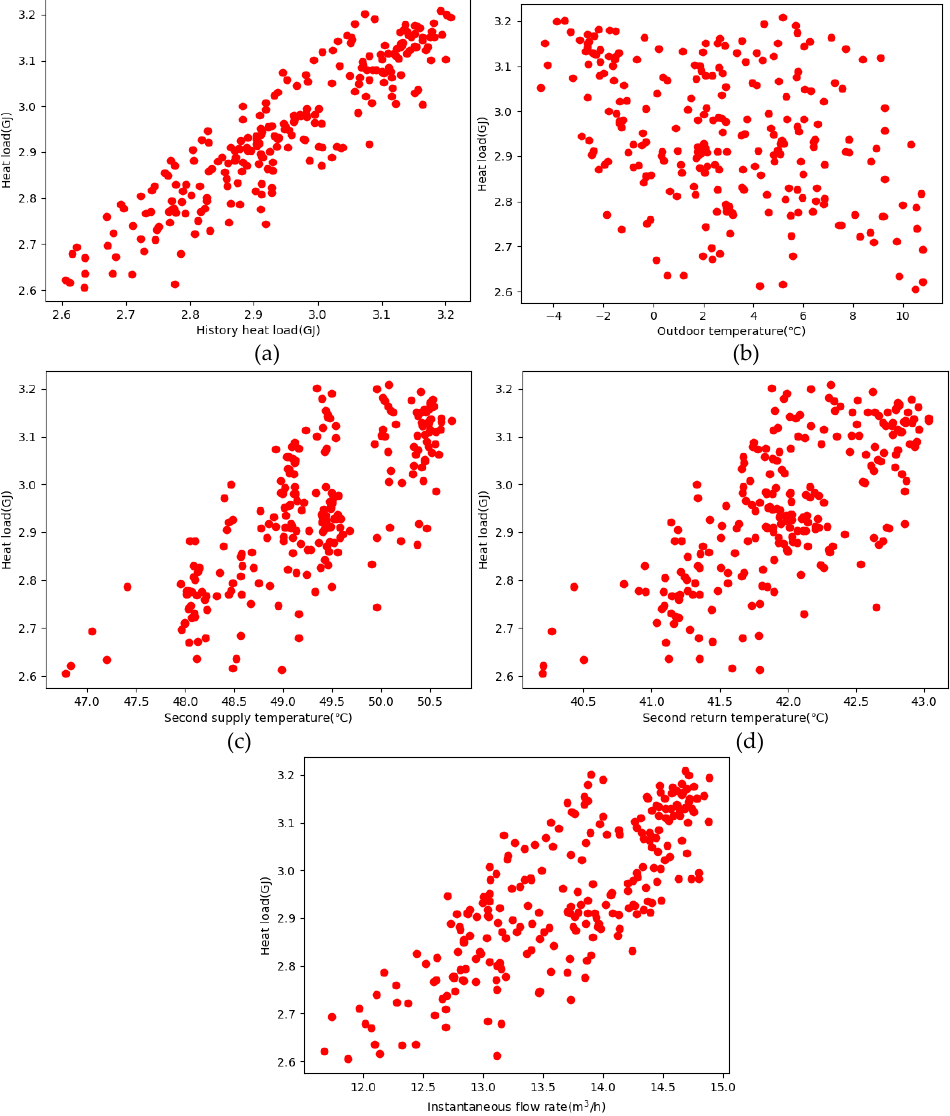
Figure 2. Correlation of heat load versus each of the influencing factors. ( a ) Historical heat load, ( b ) outdoor temperature, ( c ) second supply temperature, ( d ) second return temperature, and ( e ) instantaneous flow rate. Figure 2 indicates a high correlation of the heat load with the characteristics of the historical heat load, outdoor temperature, second supply temperature, second return temperature, and instantaneous flow rate. Thus, these characteristics might be useful predictors of the dependent variable.